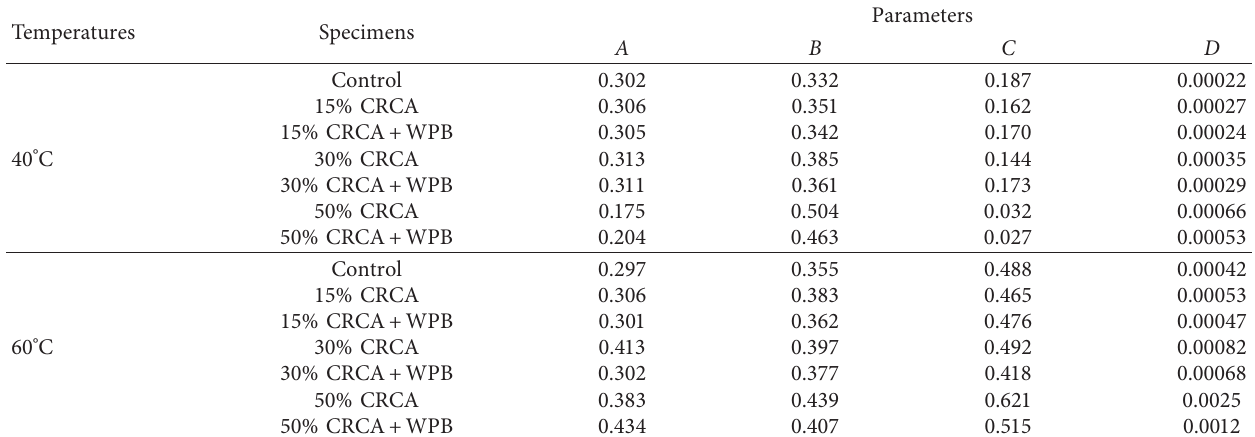
Table 5: Parameters of the Francken model.